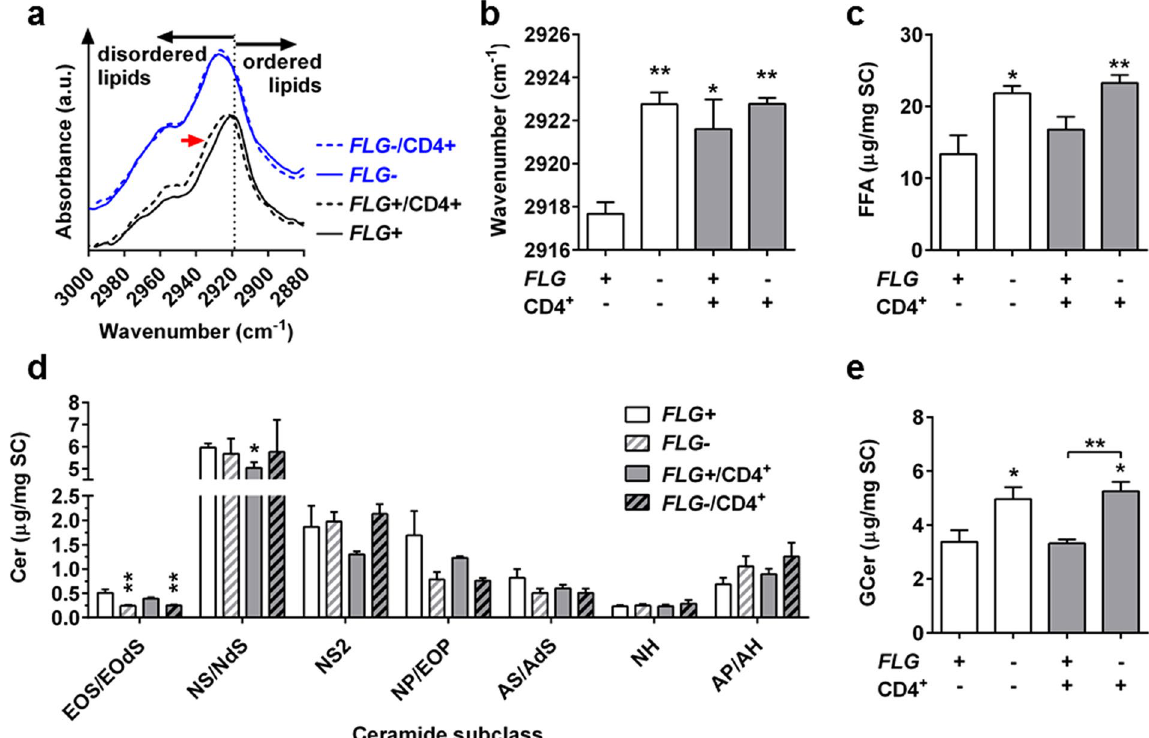
Figure 3. The presence of CD4 + T cells disorders stratum corneum (SC) barrier lipids of normal ( FLG + ), but not filaggrin-deficient ( FLG − ), skin equivalents. ( a , b ) Infrared spectroscopy of isolated SC (spectra and wavenumbers of methylene asymmetric stretching vibration). (Mean ± SEM; n = 4). ( c – e ) High-performance thin layer chromatography analysis of SC lipids (free fatty acids, ceramide subclasses and glucosylceramides) of FLG + and FLG − skin equivalents with or without exposure to activated CD4 + T cells (mean ± SEM; n = 4). * Indicates statistically significant differences between FLG + skin equivalents ( * p ≤ 0.05, ** p ≤